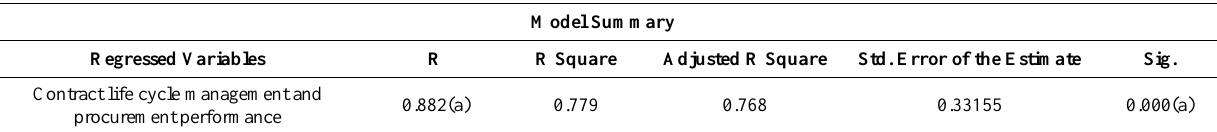
Table 3. Regression model summary showing influence of contract management on procurement performance in Bugiri District